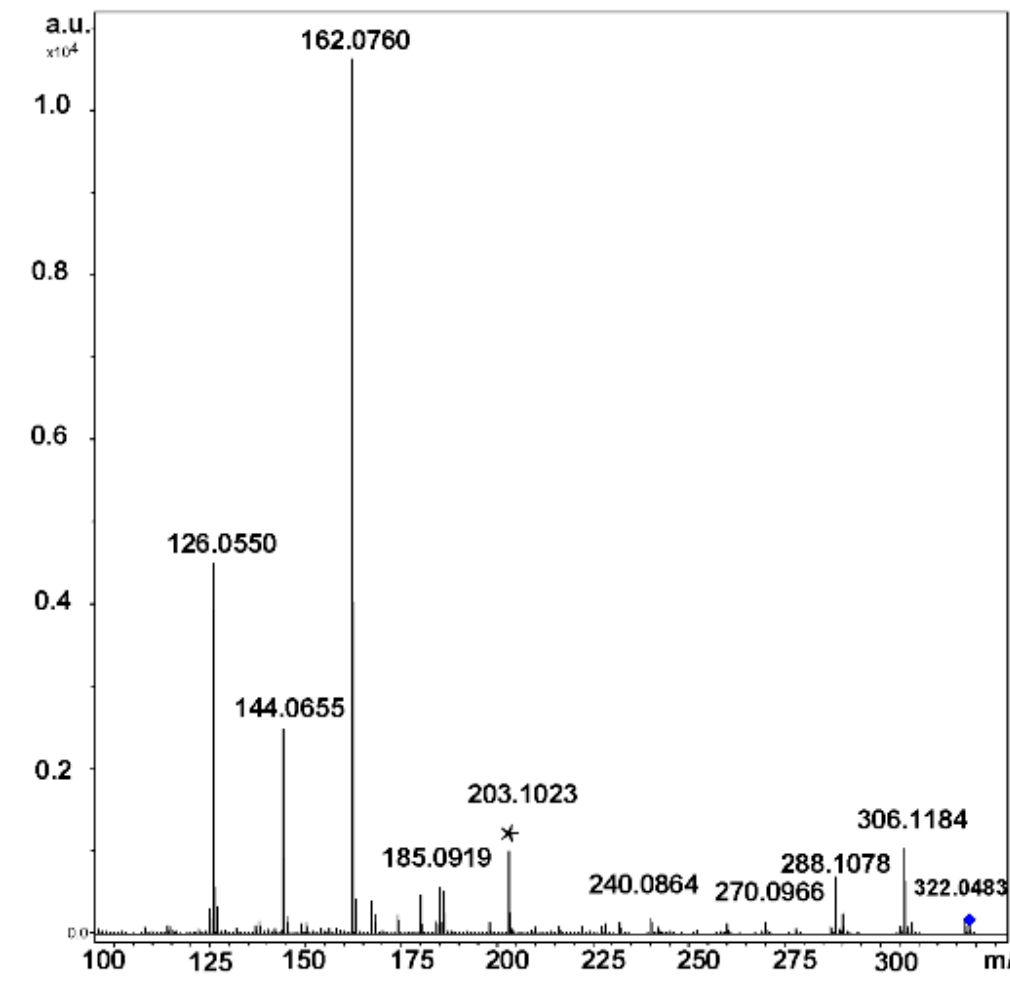
Figure 18. CID MS 2 (25 eV) of the [M + H] + ion of compound 19a (reproduced from [70] with permission of Springer Nature).